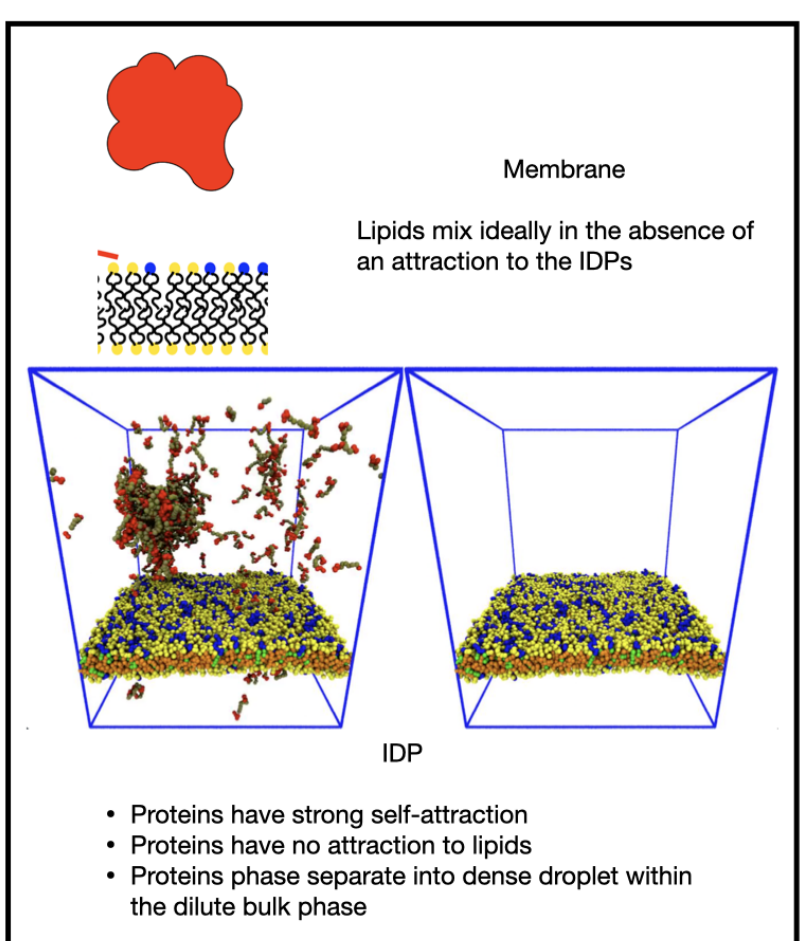
Figure 4. Equilibrium state of the system when both the IDP endcap self-attraction and attraction to the minority phase lipid headgroups are zero (solvent particles are invisible for clarity).